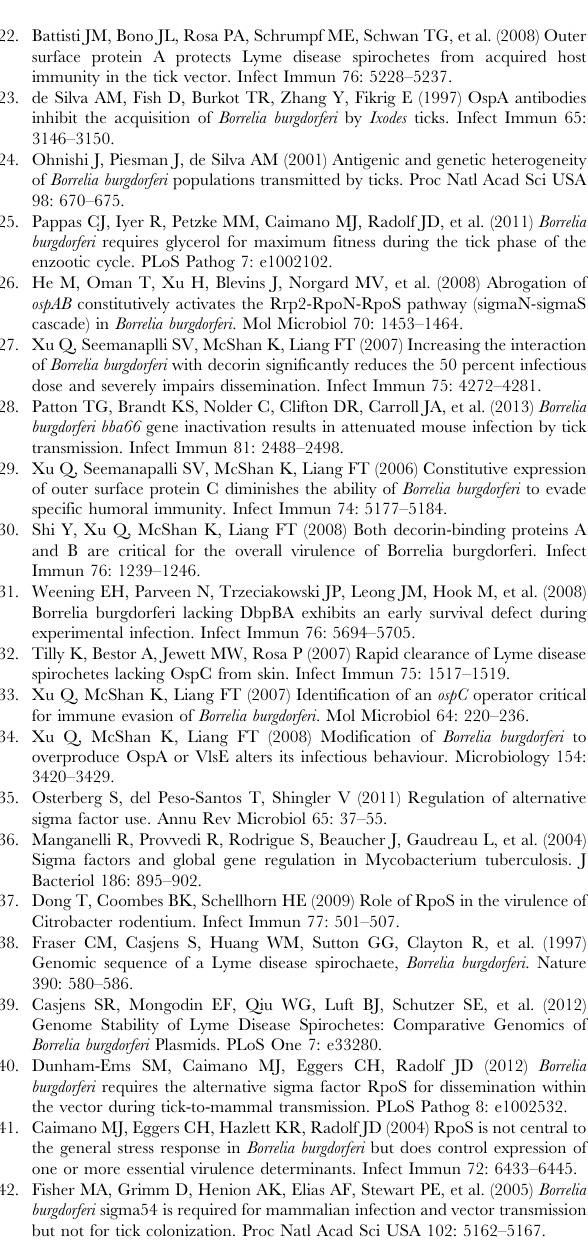
upstream inverted repeats, was incubated with purified recombi- nant BBD18 and resolved on a 5% polyacrylamide gel (B). The arrow indicating unbound DNA is directed at the specific restriction fragment containing the ospC promoter and upstream inverted repeats. Table S1 Oligonucleotide primers and probes used in this